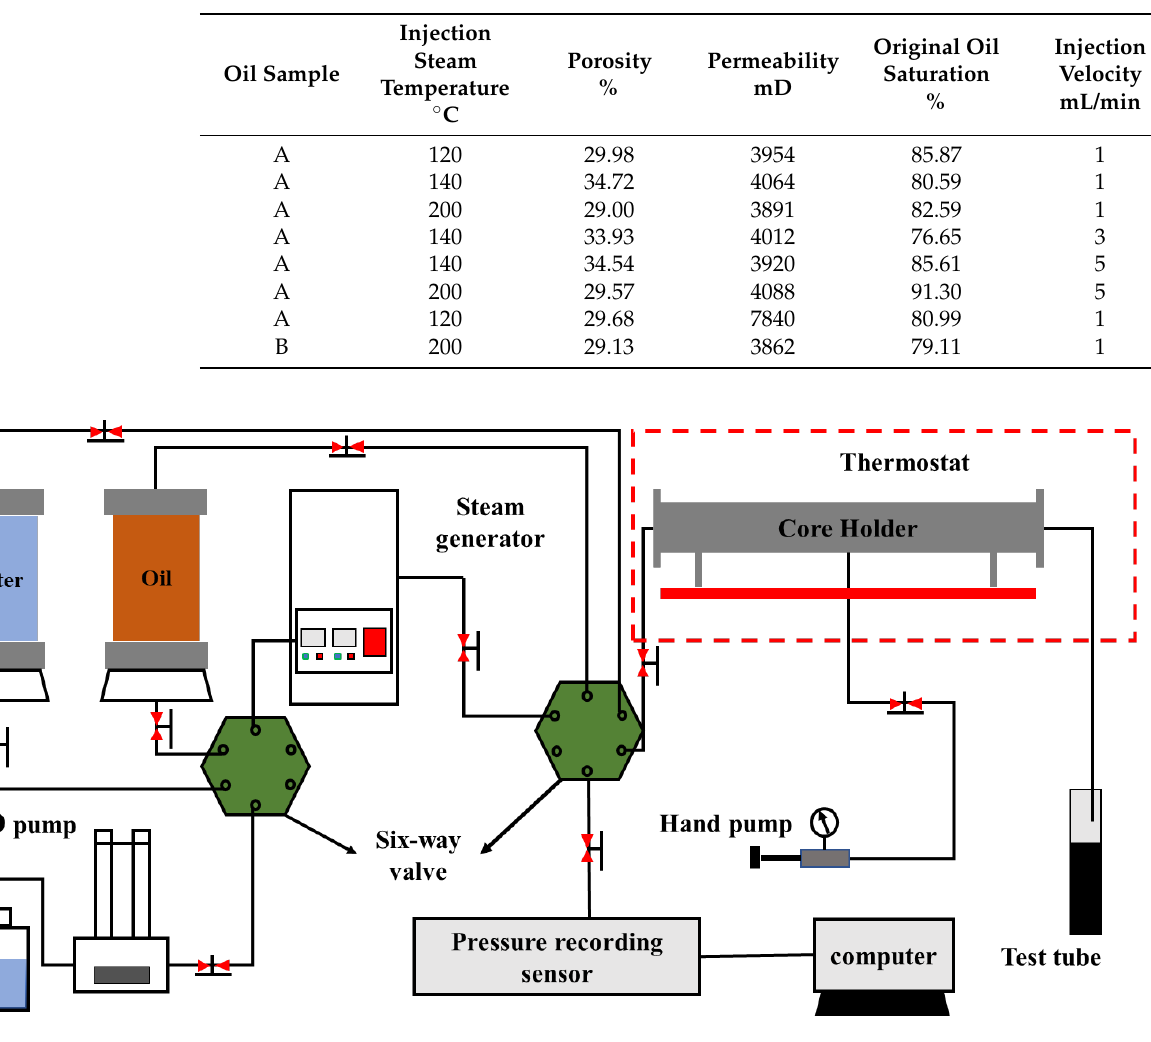
Table 2. Core physical properties and experimental schemes.